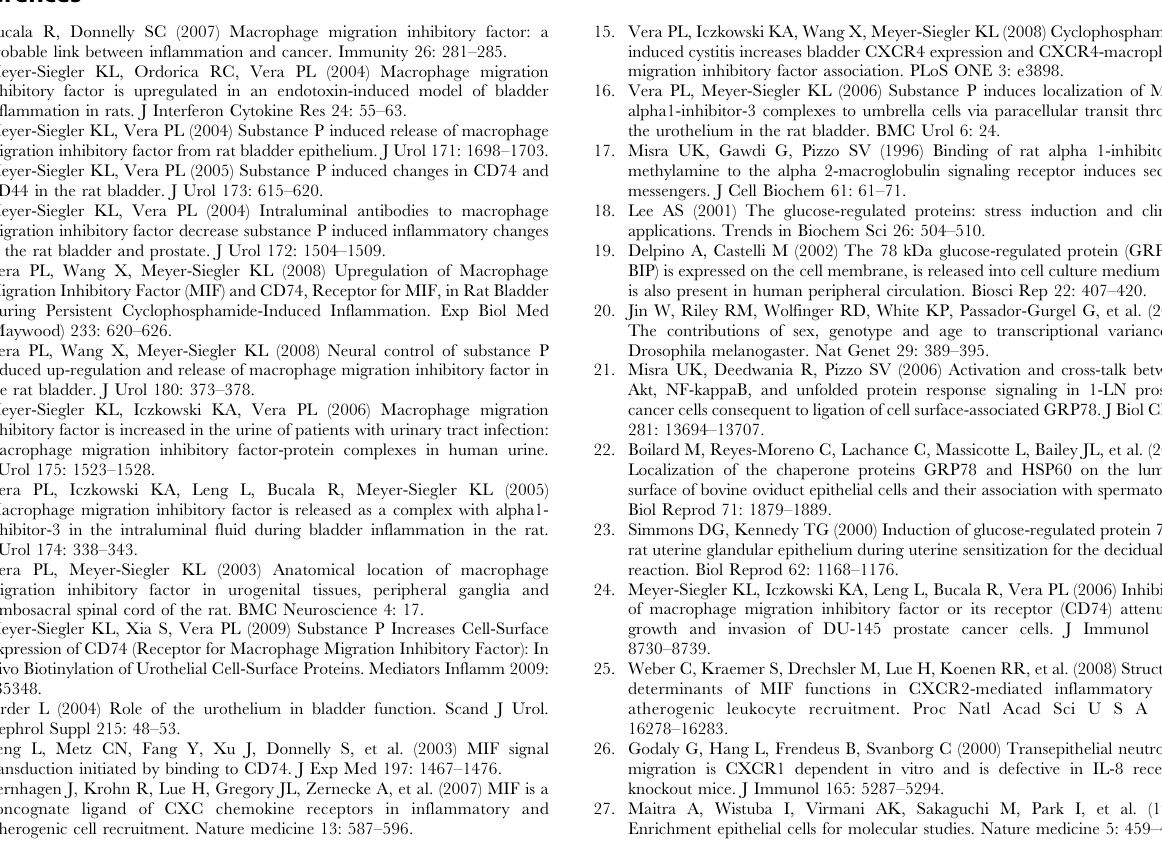
Figure 5. Volcano Plots of inflammatory gene array changes. For each plot, fold change in expression for each of the inflammatory cytokines studied (Table 2) is plotted on the abscissa while t-test significance is plotted on the y-axis. In all three plots, comparison of gene expression is made to control group (Sal (s.c.)/Sal(intraluminal). A significant change was arbitrarily defined as a 10-fold difference (vertical lines) AND a p , 0.001 (horizontal line). Using these criteria then, significant changes have been plotted using red markers, while non-significant changes are plotted using blue markers. A) Substance P treatment with saline as an intraluminal treatment (SP=Substance P(s.c.)/Saline (intraluminal) upregulated many inflammatory genes (red points in upper right quadrant). B) Intraluminal CD74 ab treatment, in SP treated rats (SP + CD74) reduced the number of inflammatory genes upregulated by SP. C) Similarly, intraluminal GRP78 ab treatment also reduced the number of genes upregulated by SP with some showing significant downregulation (red points in upper left